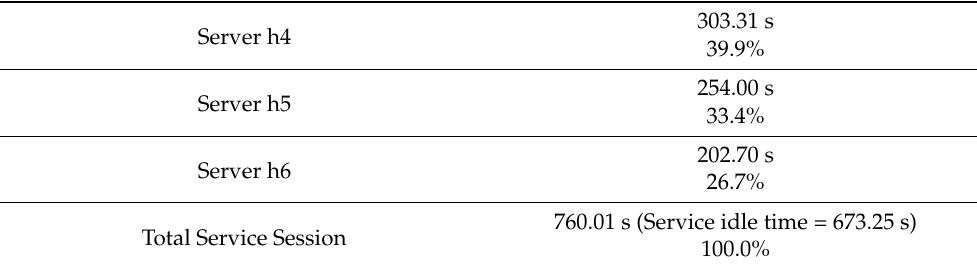
Table 6. Time distribution of edge service session among the virtualized